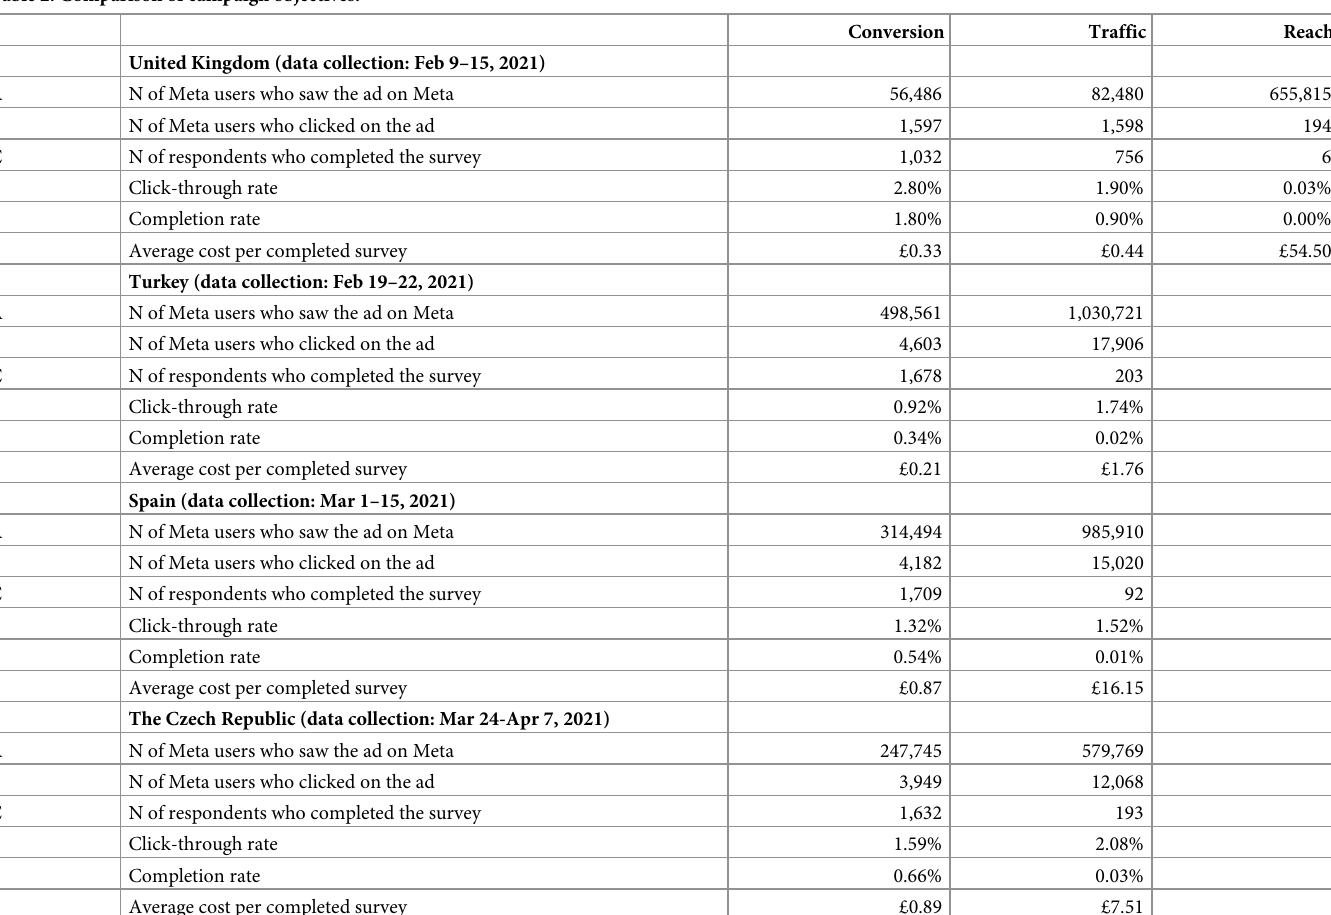
Table 2. Comparison of campaign